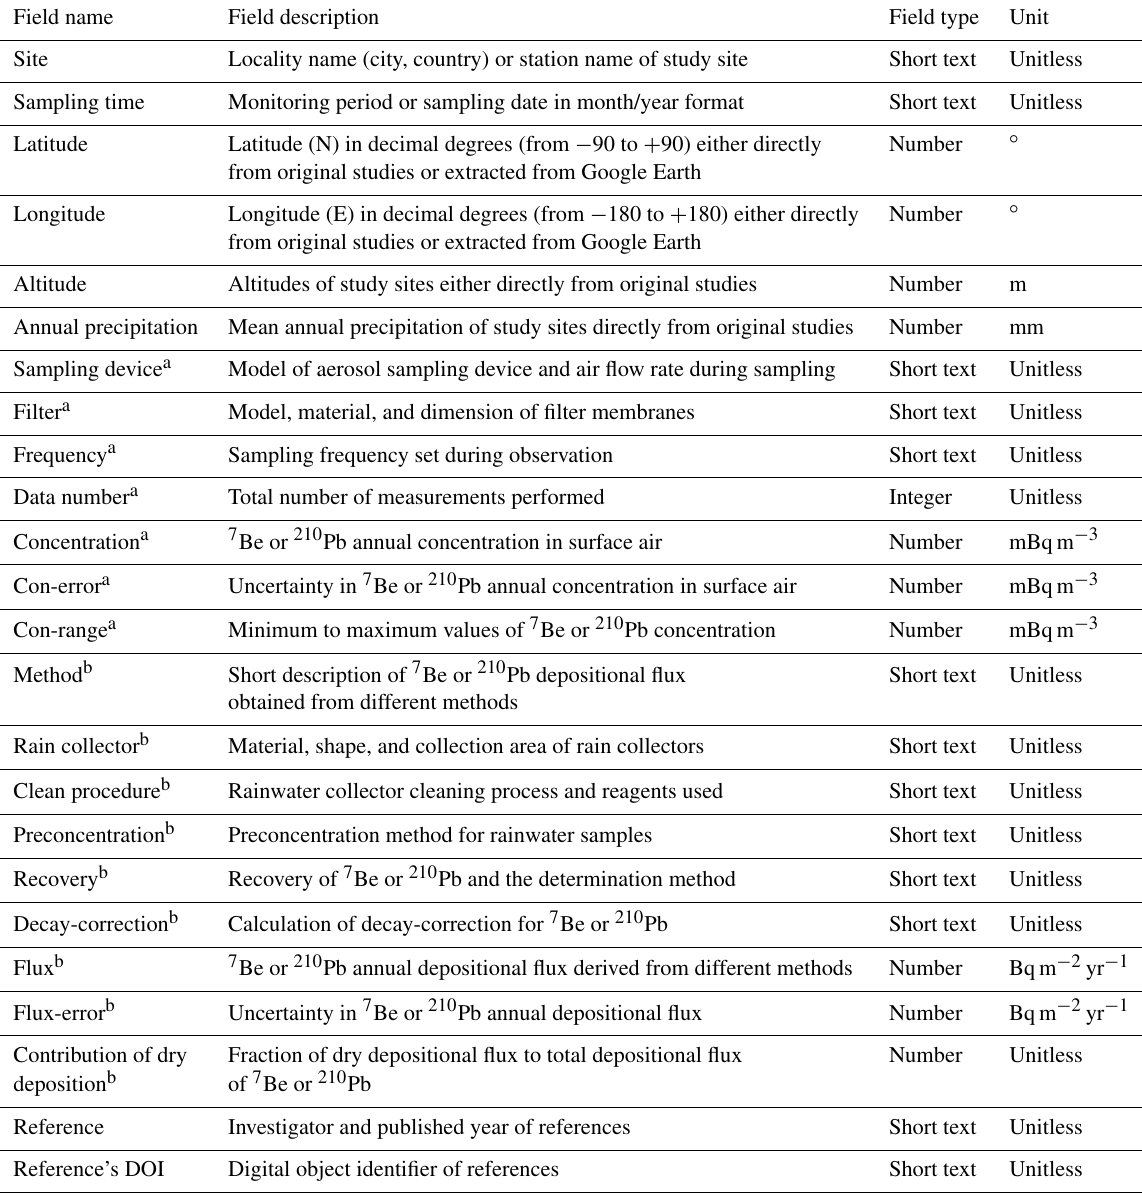
Table 1. Fields in the main data